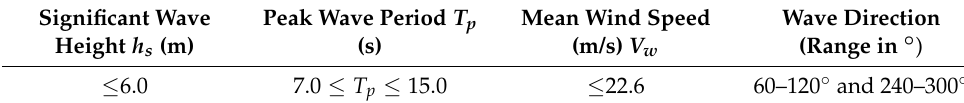
Table 1. Weather thresholds of adverse conditions. Significant